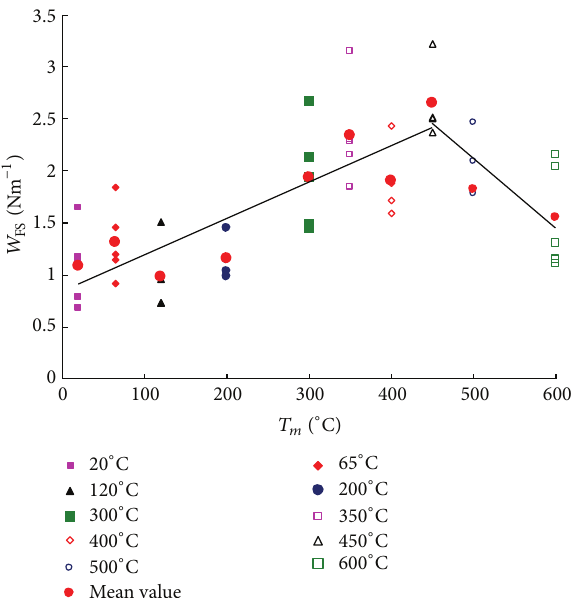
Figure 13: Stable fracture work with 𝑇 𝑚